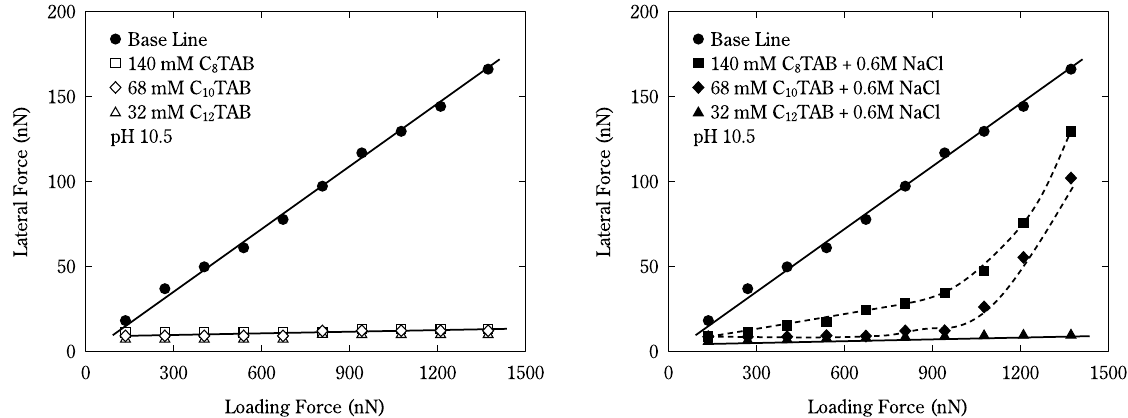
Fig. 3.2b: AFM friction force measurements on silica wafer with 7.5- μ m-size particle attached to the tip for solutions containing C 12 TAB, C 10 TAB, and C 8 TAB surfactants at 32, 68, and 140 mM concentrations in the absence of salt at pH 10.5 (on left) and in the presence of 0.6 M salt in the solution (on right) (Reprinted from reference 27 with permission from